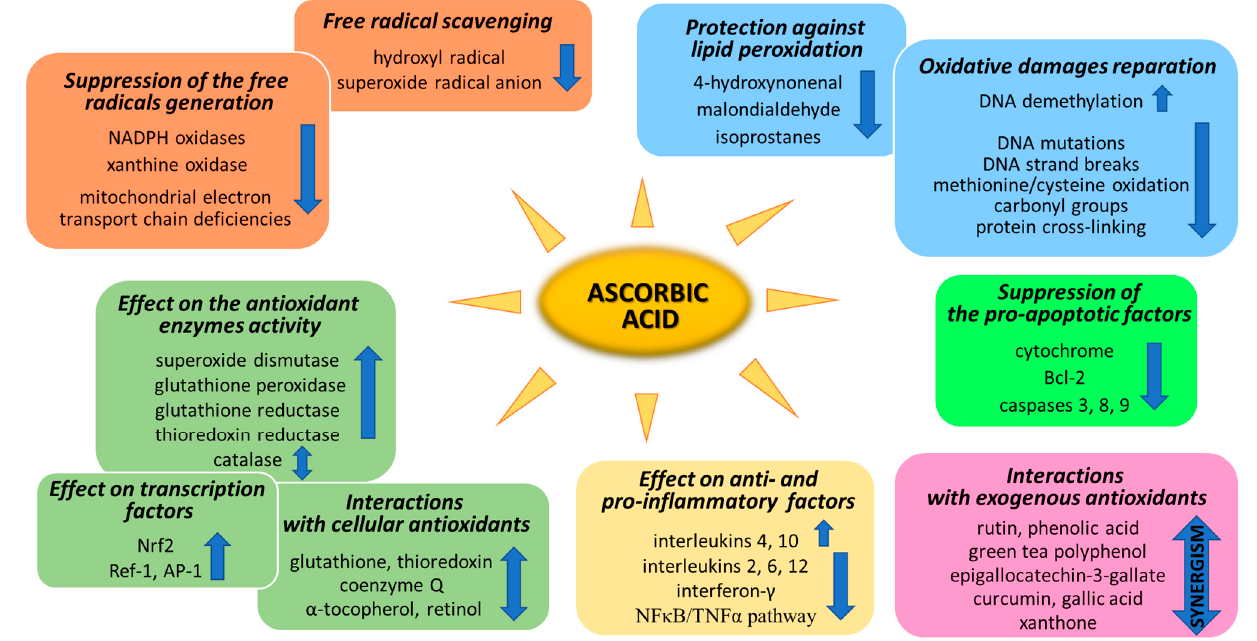
Figure 2. Pathways of the antioxidant action of ascorbic acid.